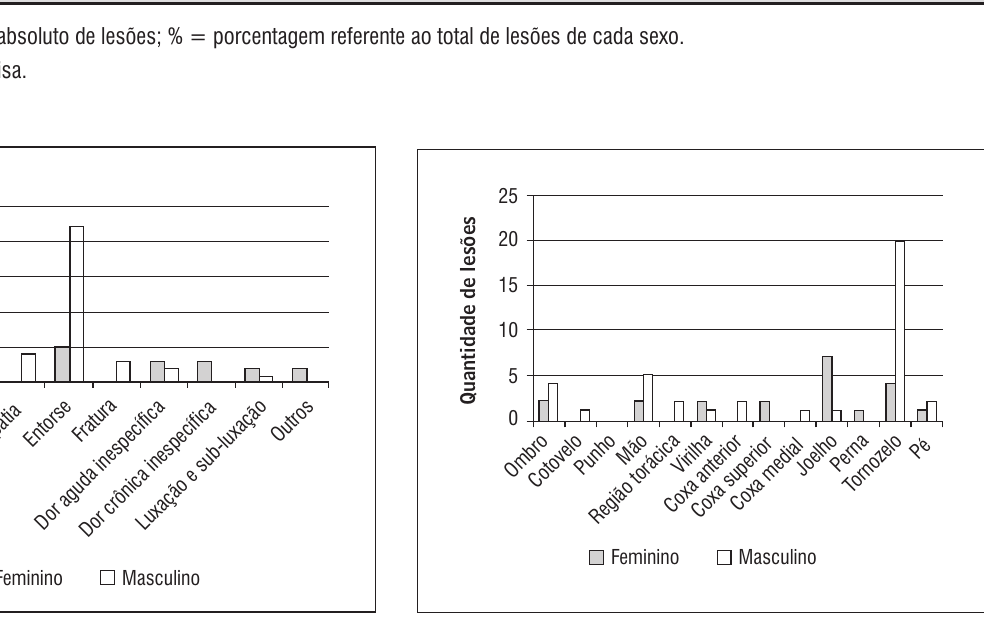
Figura 1 - Subtipos de lesão Figura 2 - Locais anatômicos em que ocorreram lesões Fonte: Dados da